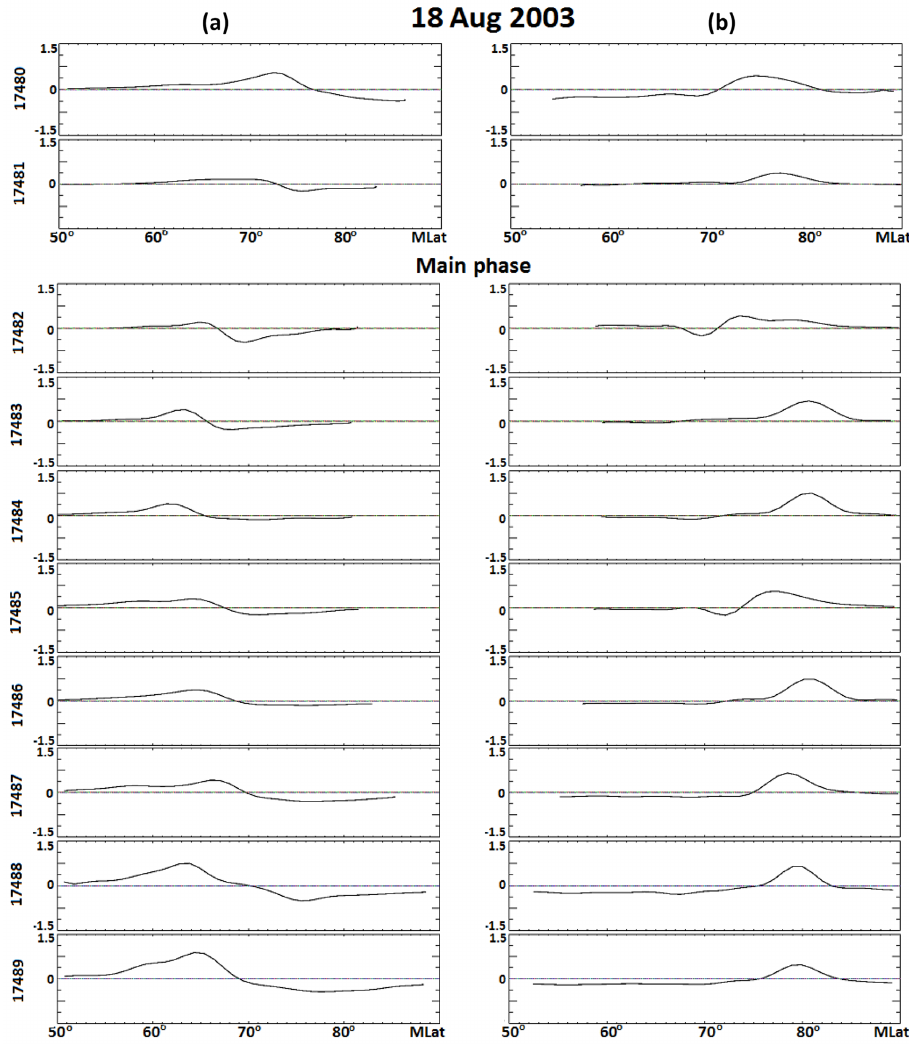
Figure A10. Direction and intensity values of the Hall current along the satellite orbit at the dawnside ( a , 07:00–09:00MLT, corresponding to the ascending section of the orbit) and duskside sectors ( b , 19:00–21:00MLT, descending orbit section). Positive currents denote an eastward current flow for the descending orbit section and a westward current for the ascending section,